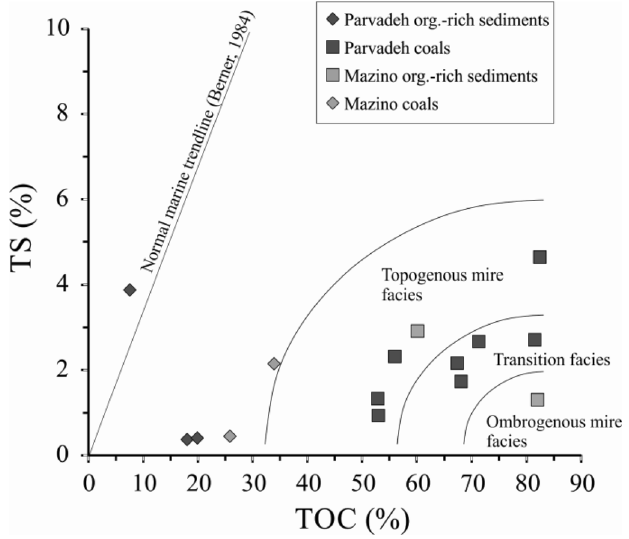
Fig. 10 Binary diagram of TS versus TOC for organic-rich sediment and coal samples of the Parvadeh and Mazino coalfields. Depositional facies after Jasper et al.